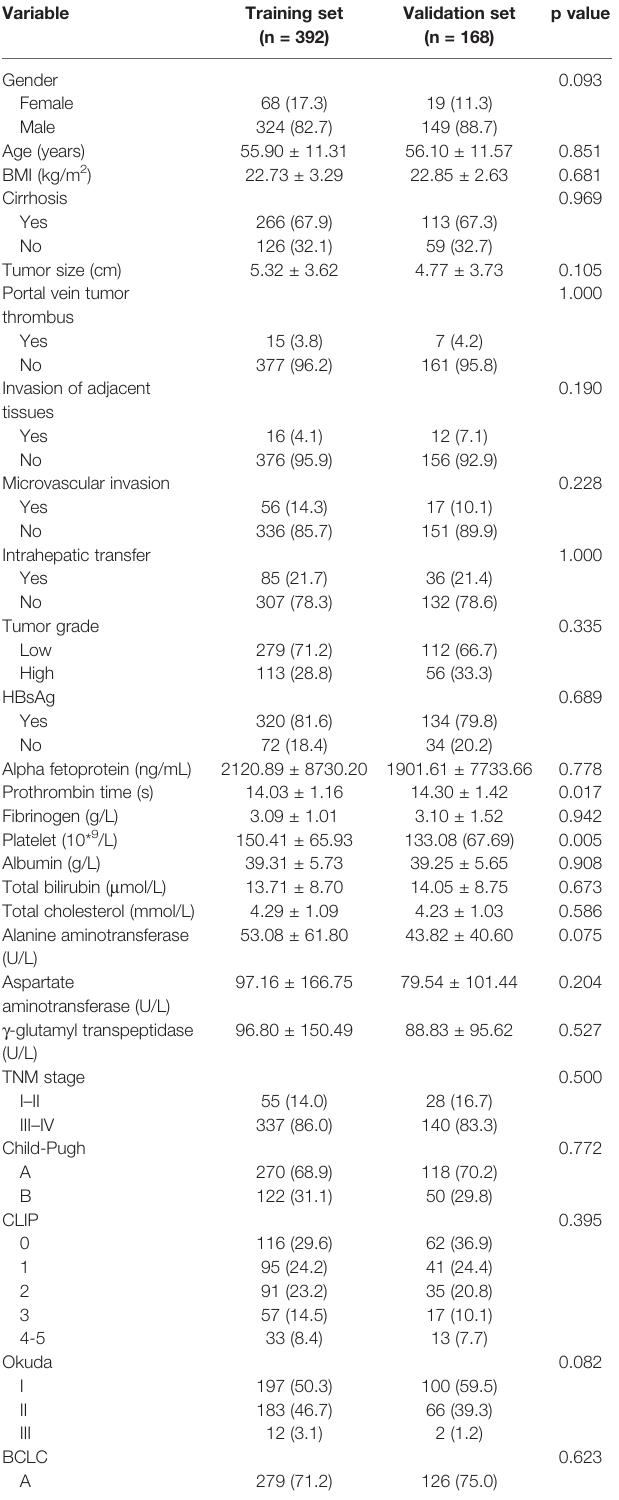
Prognostic Factors of the Training Cohort Univariate risk factors of overall survival (OS) are shown in Table 2 . The results showed that classi fi cations of Child – Pugh, BCLC, TNM, Okuda and CLIP, as well as tumor size, PVTT, invasion of adjacent tissues, microvascular invasion, intrahepatic transfer, tumor grade, prothrombin time, and levels of fi brinogen, albumin, total bilirubin, total cholesterol, ALT and GGT were signi fi cant indicators of OS. These signi fi cant indicators from the univariate analysis (p values less than 0.05), but not the other classi fi cation systems, were included in the multivariate analysis to build a simple nomogram. The results showed that tumor size, PVTT, invasion of adjacent tissues, microvascular invasion, fi brinogen and total bilirubin were independent prognostic factors for OS ( Table 3 ).